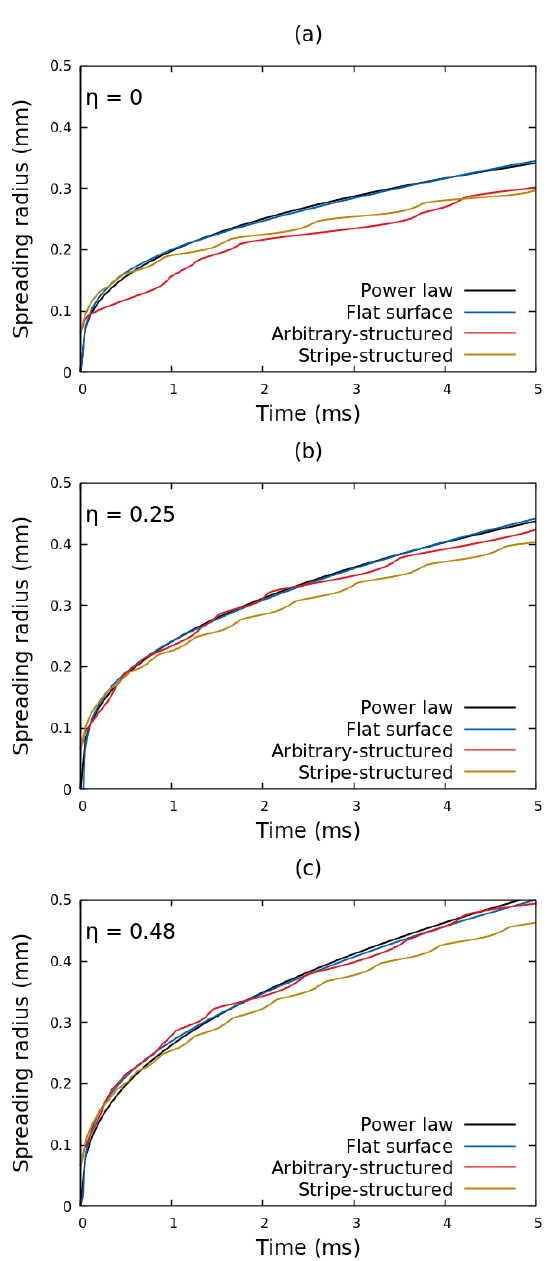
Figure 4. Temporal evolution of the contact radius of a glycerin droplet, spreading under the effect of electric field, for various solid dielectrics and electrowetting number, η , cases: ( a ) η = 0, ( b ) η = 0.25 and ( c ) η = 0.48. A power-law, r s = Ct a , which describes the spreading dynamics, is also visualized. The power-law exponents, a , fitted on the flat surface case are: ( a ) 0.34, ( b ) 0.37 and ( c ) 0.41. The dielectric thickness, d , is set to 50 µ m for all